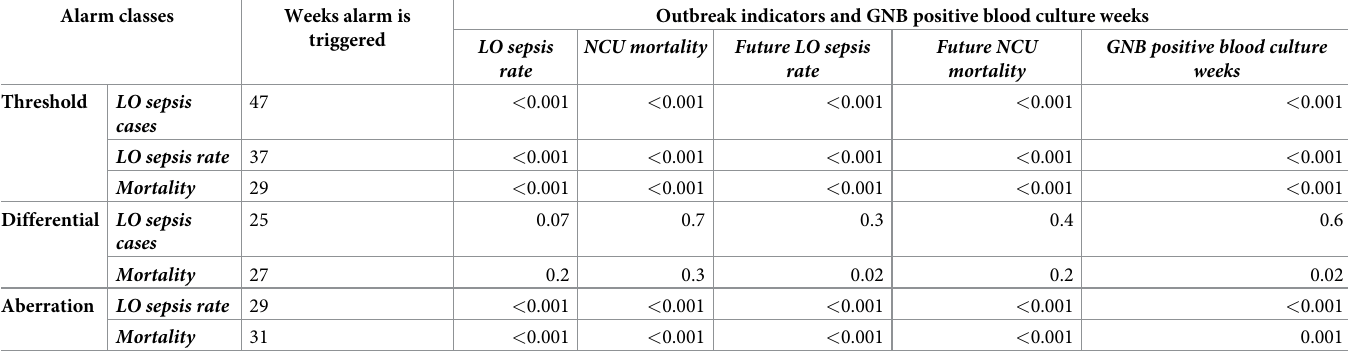
Table 3. Performance (p-values) of the alarm classes in predicting abnormal values of outbreak indicators and weeks in which GNB positive blood cultures are reported (columns). Alarm classes Weeks alarm is Outbreak indicators and GNB positive blood culture weeks triggered NCU mortality Future LO sepsis LO sepsis rate